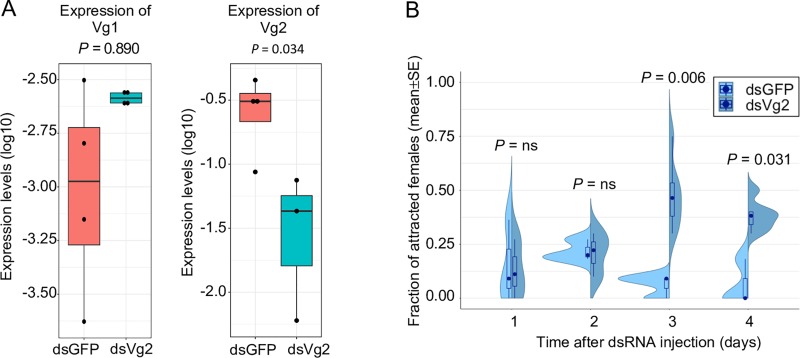
Fat body–specific vitellogenin gene expression regulates host-seeking behaviour.(a) Verification of the Vg-2 knockdown efficiency after dsRNA injection via RT-qPCR. dsRNA was injected into newly emerged females (<24 h of age), and gene expression of Vg-1 and Vg-2 was measured in the fat bodies of 5-day–old females. 4 biological replicates (i.e., pools of 4 fat bodies) were used for each injection type. Injection of dsVg2 significantly reduced Vg-2 gene expression compared to controls (dsGFP-injected females) but did not affect Vg-1 gene expression based on Welsh’s t test. (b) The dsVg2 knockdown significantly increased the host-seeking behaviour of 4- to 5-day–old females (i.e., 3–4 days after dsRNA injection) based on pairwise Mantel–Haenszel χ2 tests with Benjamini–Hochberg FDR correction. N = 3 (days 1–2), N = 6 (days 3–4). The underlying data can be found within S2 Data. dsGFP, double-stranded RNA of the Green Fluorescent Protein; dsRNA, double-stranded RNA; dsVg2, double-stranded RNA of Vitellogenin 2; FDR, False Discovery Rate; RT-qPCR, Reverse Transcriptase quantitative polymerase chain reaction; Vg, vitellogenin.